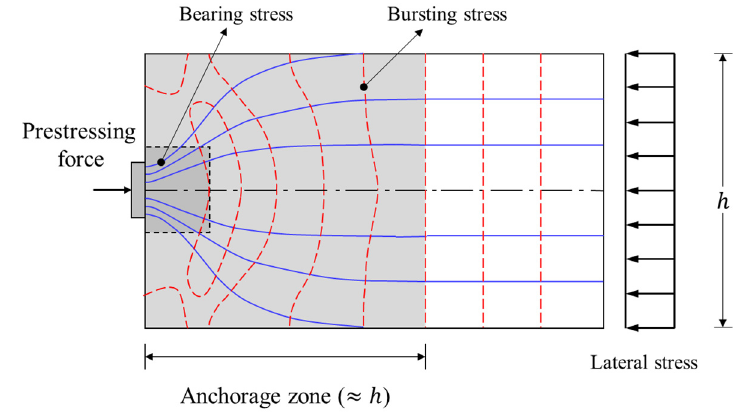
Figure 1. Stress distribution at the anchorage zone in a post-tensioned member.